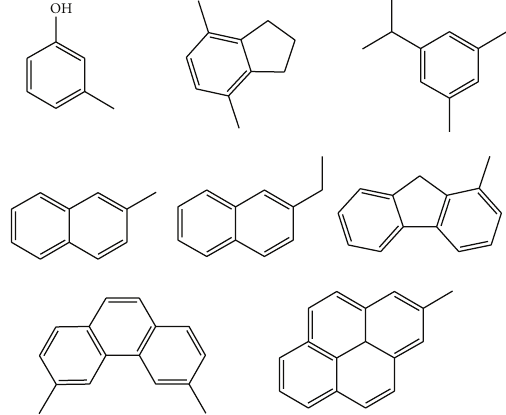
Figure 5: Relationship between the total PAHs cracking rate and particle size of Fe 2 O 3 .